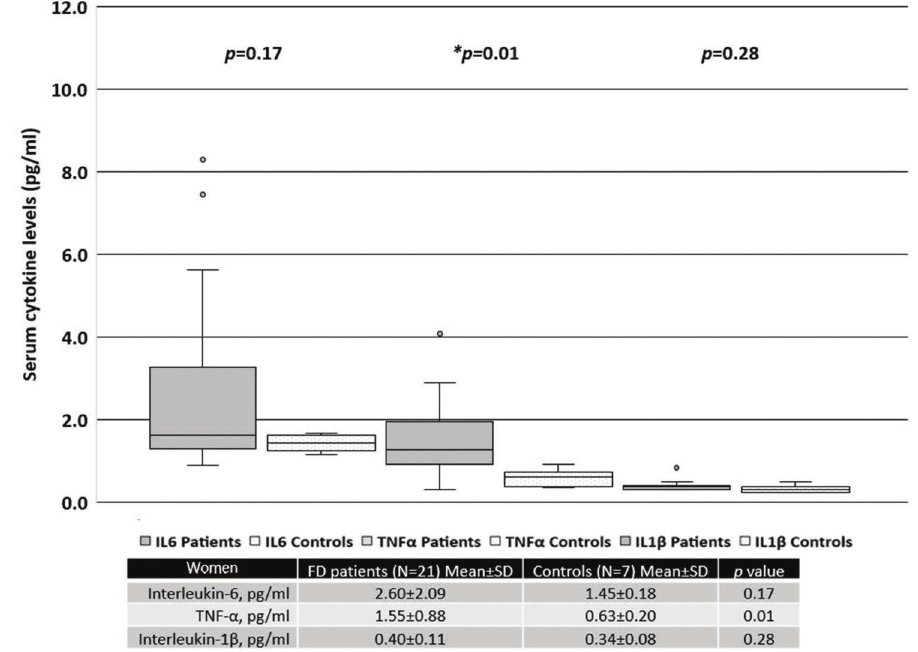
Figure 2 - Serum cytokine levels in women with FD versus those in the control subjects.